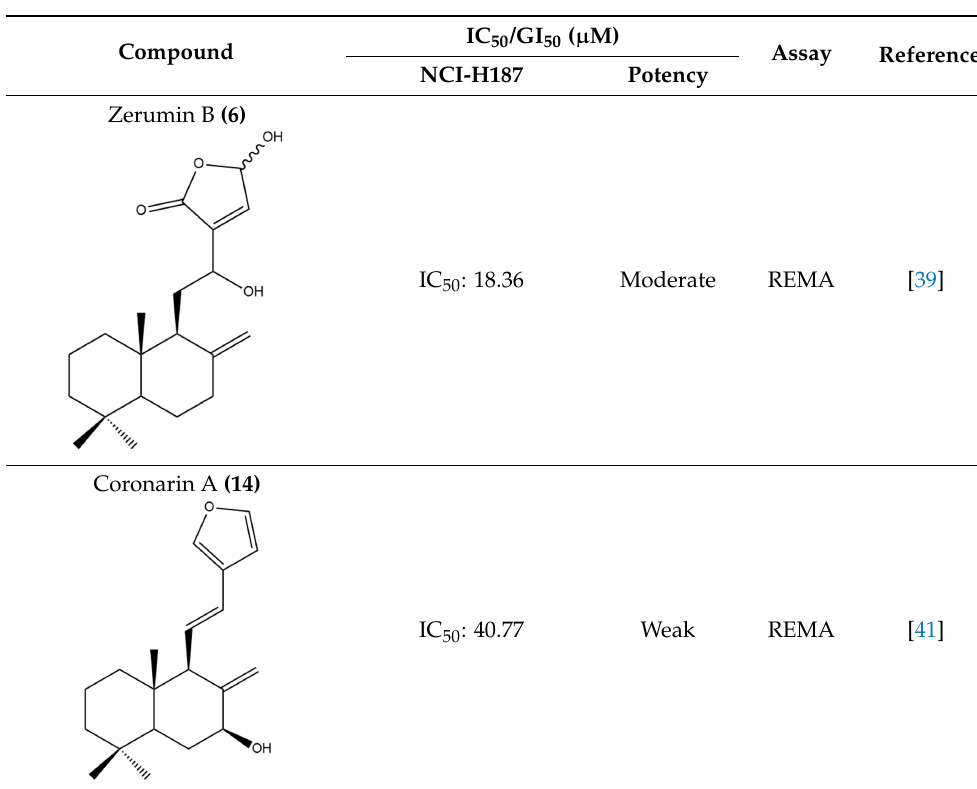
Table 19. Cytotoxic activities of labdane-type diterpenes from the Zingiberaceae against NCI-H187 lung cancer cell line.